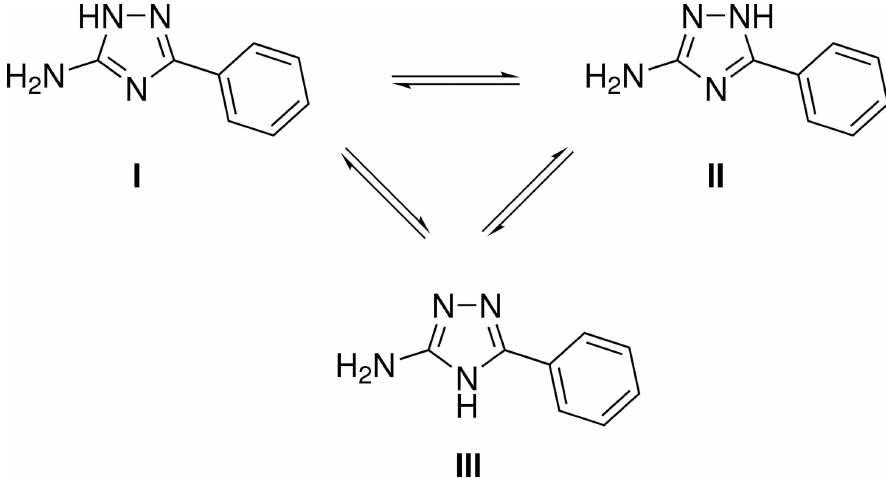
Figure 1 Possible tautomers of 3(5)-phenyl-1,2,4-triazol-5(3)-amine.